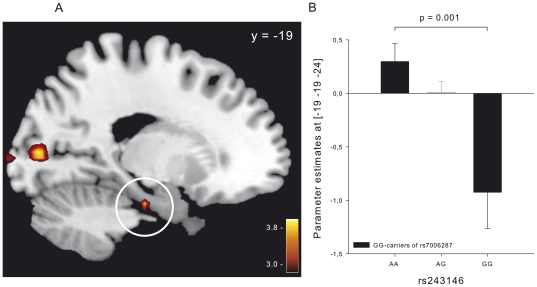
SNP rs243146 genotype-dependent differences in brain activity in the parahippocampal gyrus of rs7006287 GG-carriers during memory encoding.(A) Gene dose-dependent (with increasing numbers of A alleles) increases in activity in the left parahippocampal gyrus (P = 0.001, displayed at an uncorrected threshold of P = 0.005). The white circle indicates the activation in the left parahippocampal gyrus. (B) Parameter estimates at the peak voxel in the left parahippocampal gyrus (−19, −19, −24).